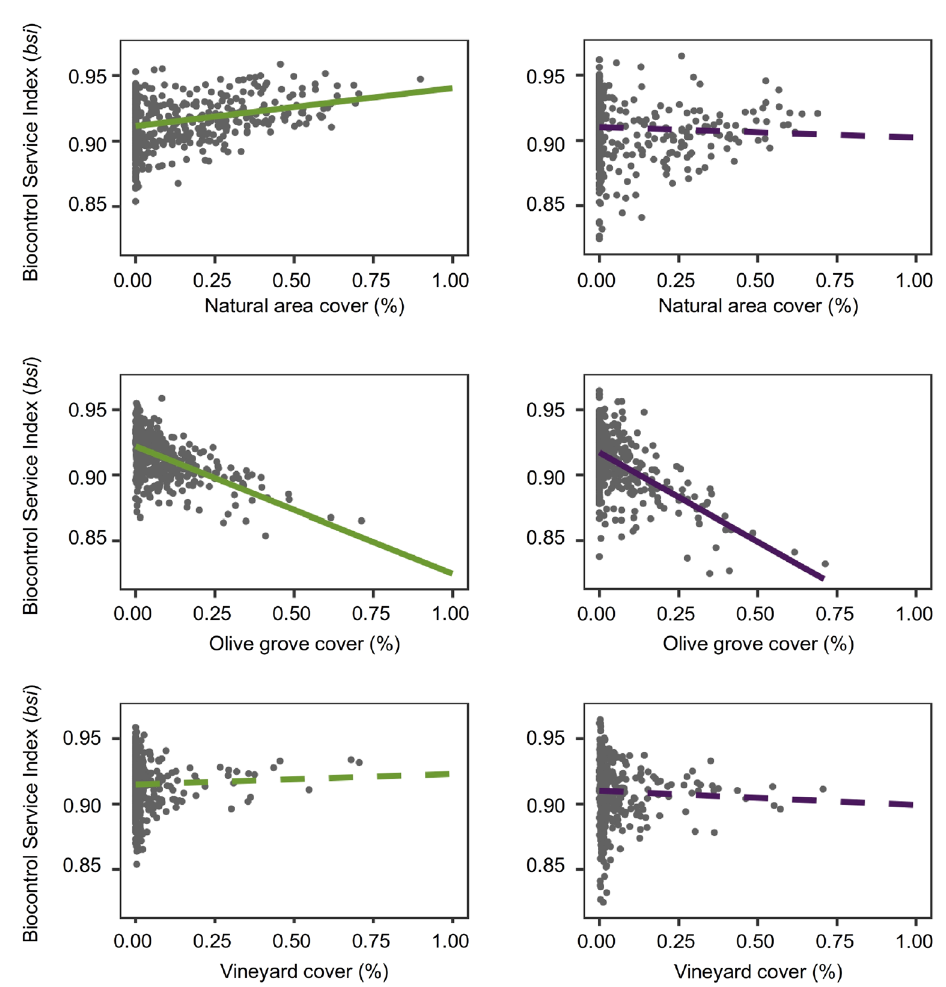
Figure 4. Linear relationships between biocontrol services indices ( bsi ) and landscape composition (proportions of natural area and that of each crop at 10 × 10 km grid cells) estimated for olive groves (left panels) and vineyards (right panels). Significant relationships between bsi and landscape composition are shown using continuous lines, while non-significant relationships are shown using dashed lines (see Table